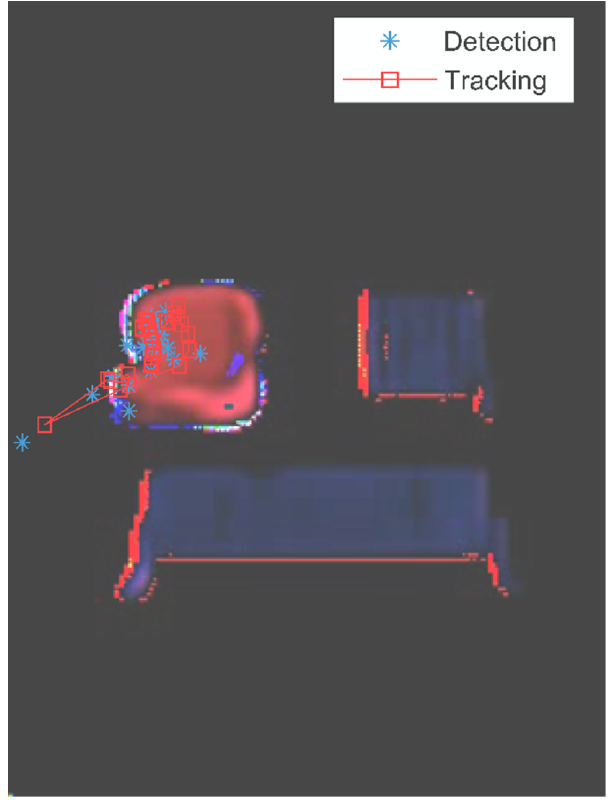
Figure 8. The tracking result of the intended left seat part.